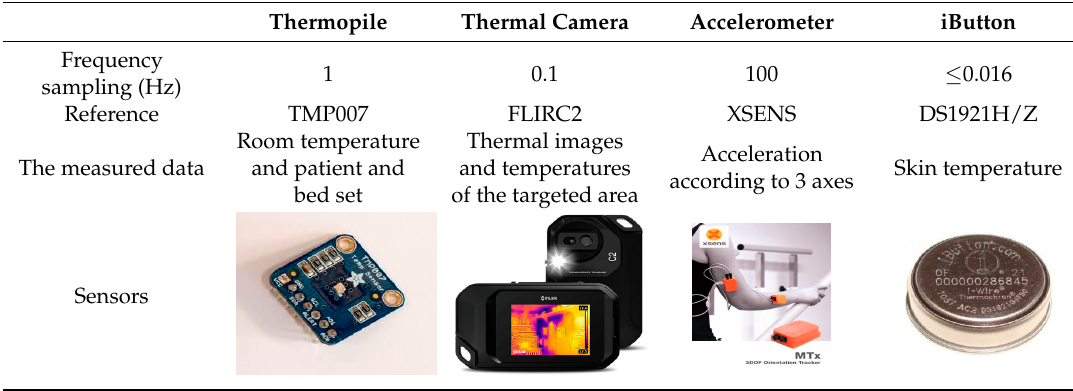
Table 1. Description of the sensors.